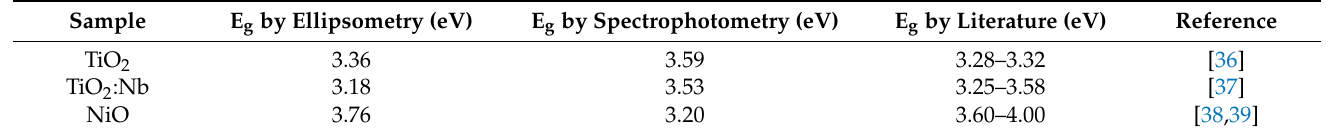
Table 4. Energy band gap values from spectrophotometric and ellipsometric measurements.